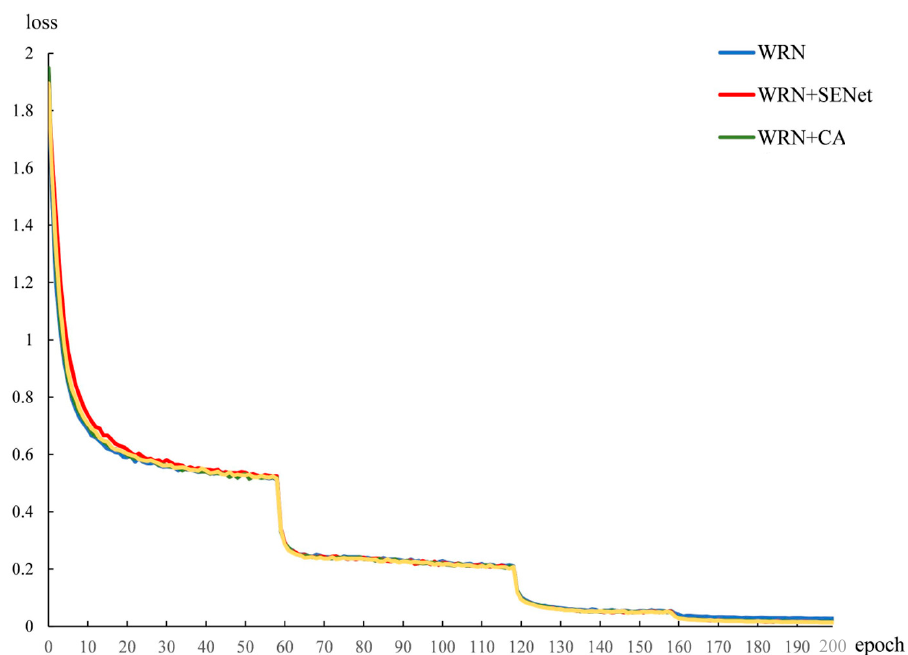
Figure 7. Convergence curve of the model training loss